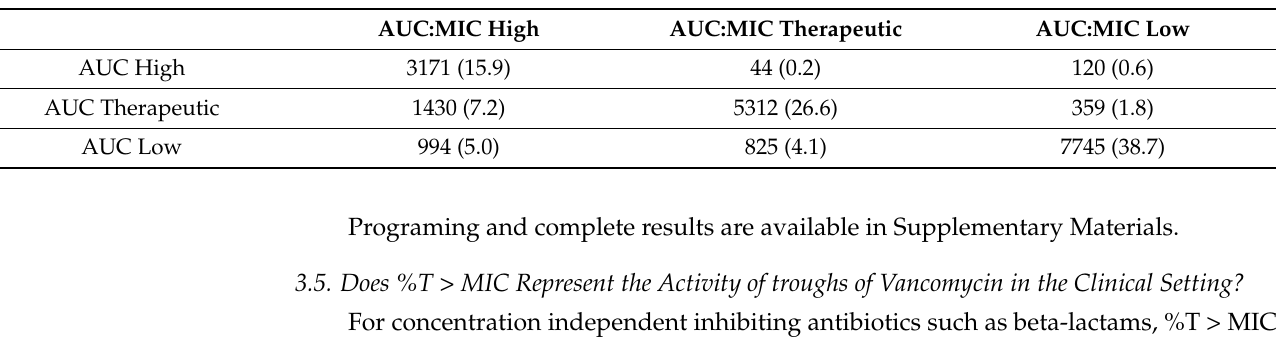
11 of 15 Table 3. Results of Monte Carlo Simulations—random pairing of AUC 24 to MIC to calculate AUC 24 :MIC (see text for details). Simulation Number 1.211 Table 4. Agreement of dosing assessments by AUC versus AUC